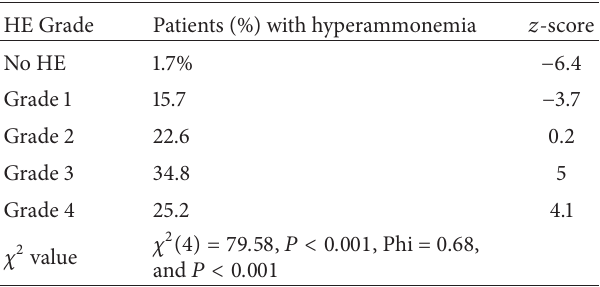
Table 6: Chi-square test statistics of distribution of hyperammone- mia across different grades of hepatic encephalopathy